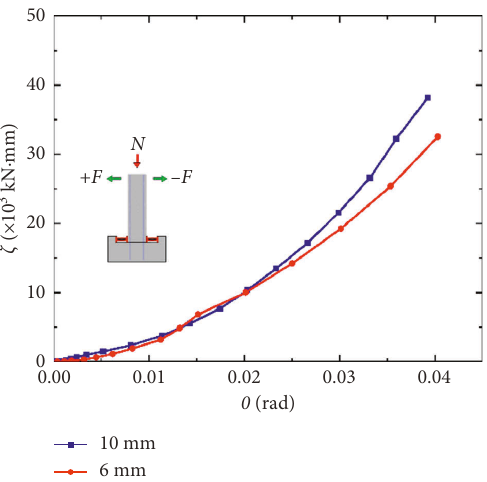
Figure 28: Comparison of cumulative energy dissipators coeffi- cient ζ of specimens with different energy dissipator